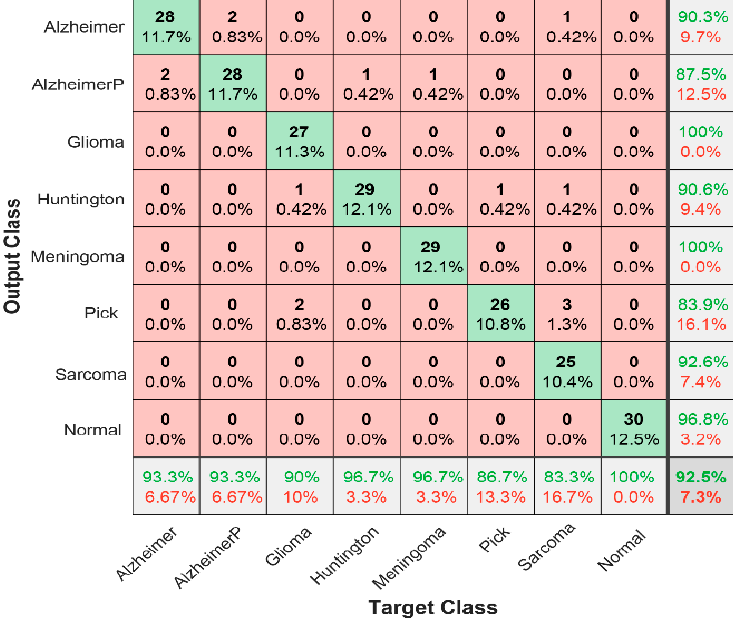
Figure 12. The confusion matrix for eight-classes states using PCA-LDA (WLK).